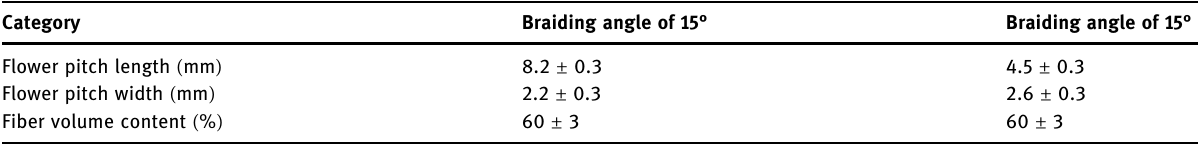
Table 2: Material